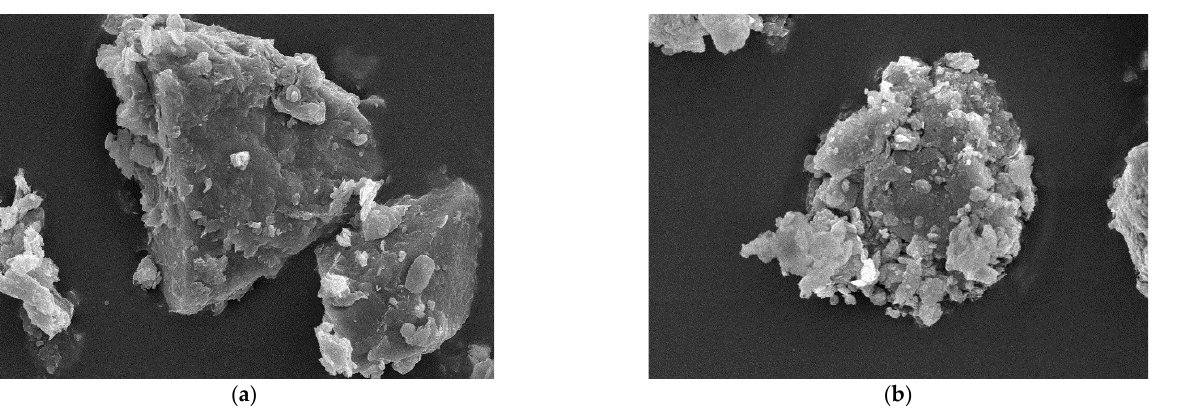
Figure 3. Clay samples image under a scanning electron microscope (Y-Clay ( a ) and L-Clay ( b )).